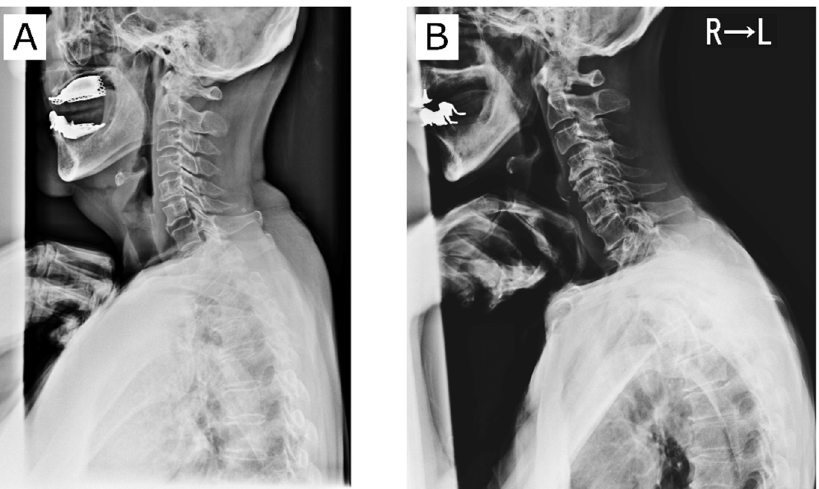
Figure 4. Effect of cervical spondylotic changes on cervical spine alignment. Notes: Case ( A ) (female) has a compensated cervical spine. Case ( B ) (male) has a decompensated cervical spine.